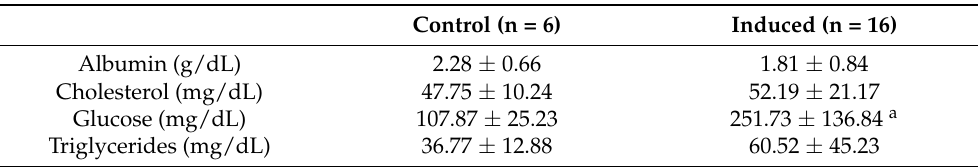
Table 4. Albumin, total cholesterol, glucose, and triglycerides serum levels per group after animals’ euthanasia.